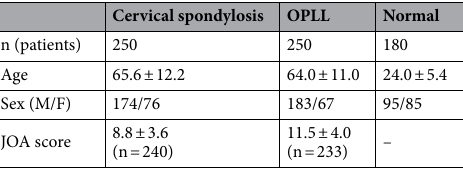
Table 1. Baseline patient characteristics. JOA Japanese Orthopaedic Association, OPLL ossification of posterior longitudinal ligament.